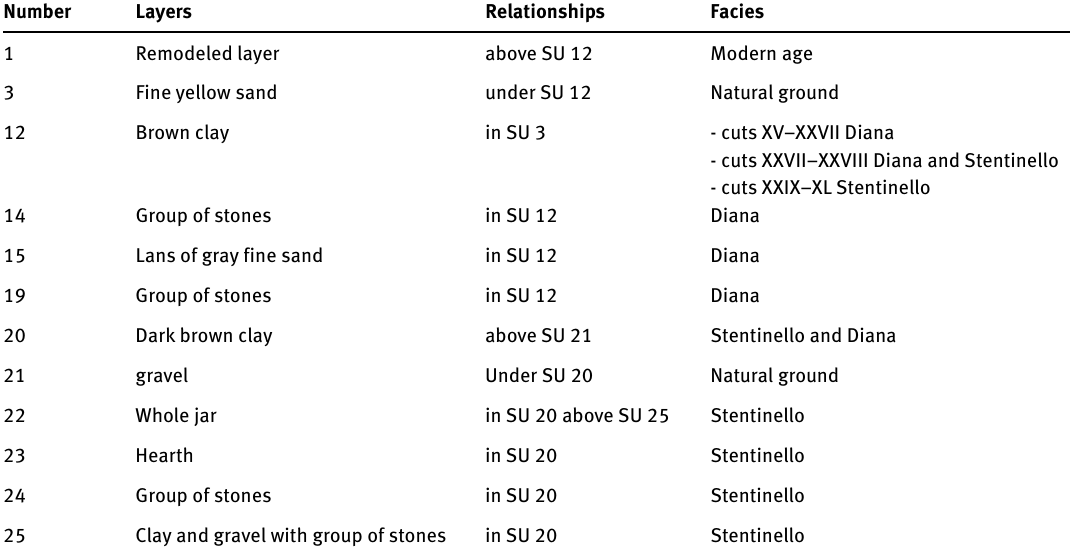
Figure 3. S. Martino. Stratigraphic section B’- B. Table 1. Archaeological layers and stratigraphic sequence from the site of S.